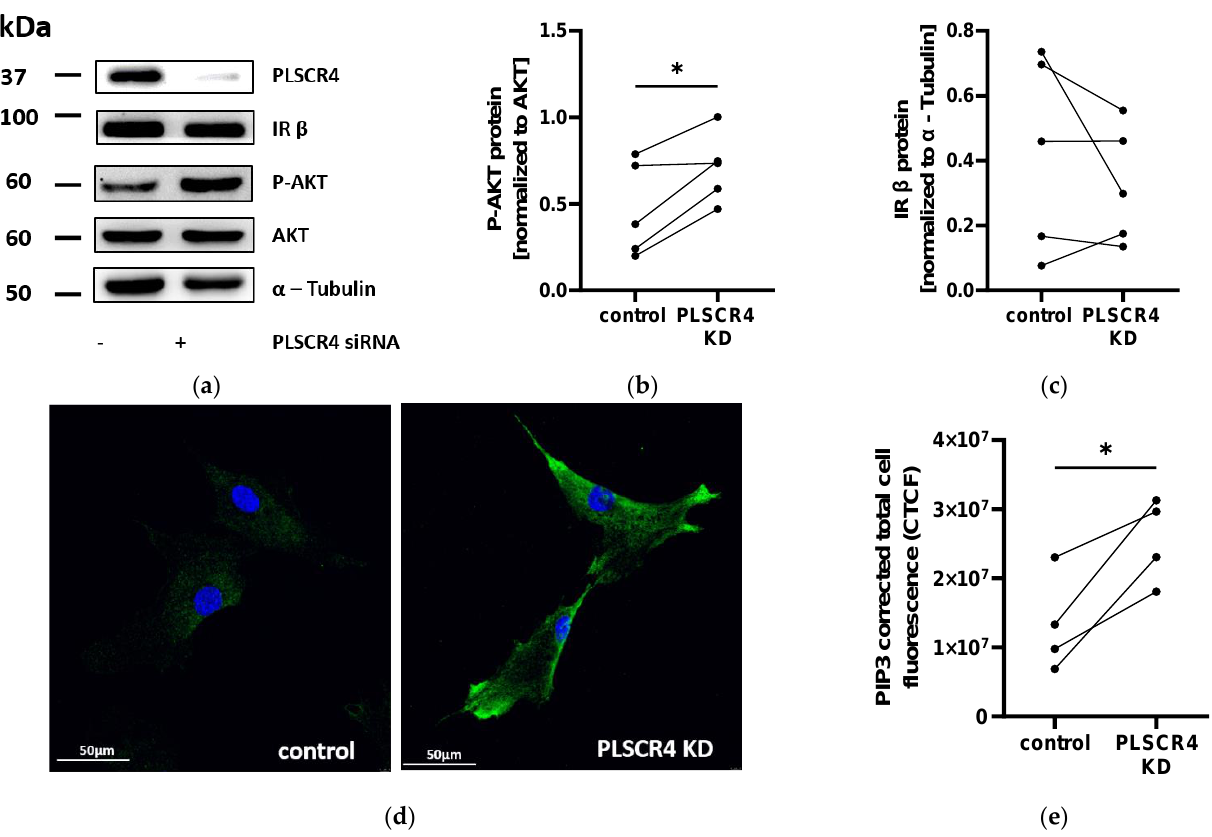
Figure 5. AKT phosphorylation and PIP3 immunofluorescence staining was increased in PLSCR4 knockdown (KD) adipocyte progenitor cells (APCs). ( a ) Western blots of PLSCR4, insulin receptor β subunit (IR β), and phosphorylated AKT (p-AKT T308) in PLSCR4 KD APCs, one representative image each. ( b ) AKT phosphorylation in PLSCR4 KD cells was increased by 52.0% ± 13.6% com- pared with control cells (phosphorylated AKT (p-AKT T308) normalized to total AKT protein; n = 5; p = 0.0186) ( c ) IR β subunit expression was variable between control cells and PLSCR4 KD cells and showed no r egulation (IR β normalized to α -Tubulin; n = 5; p = 0.3283). ( d ) Hoechst nuclear staining (blue) and PIP3 immunofluorescence staining (green) in PLSCR4 KD and control APCs. ( e ) Analysis of corrected total cell fluorescence via ImageJ showed that PIP3 fluorescence was increased 1.92 ± 0.21-fold in PLSCR4 KD cells compared with controls ( n = 4; p = 0.0226). Lines between indi- vidual data points indicate matched data from single experiments (control versus PLSCR4 KD). p - values for the experiments were determined via paired t -test (* p < 0.05). PLSCR4, phospholipid scramblase 4; IR β , Insulin receptor β subunit; AKT, serine/threonine kinase protein kinase B; p- AKT, phosphorylated AKT (T308).